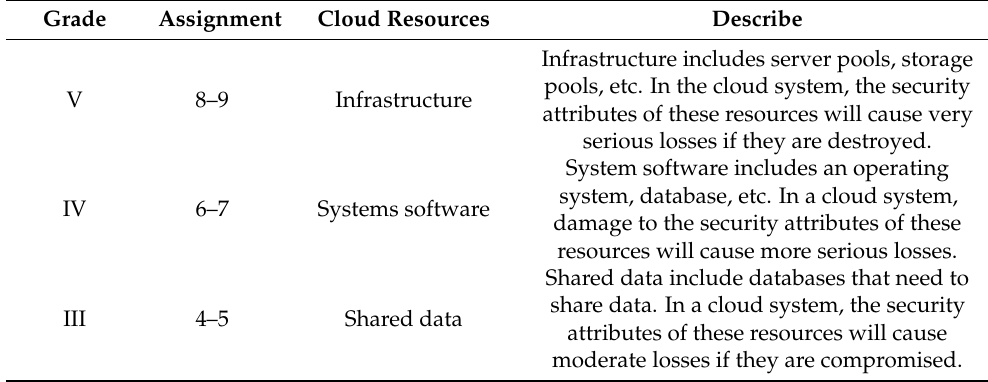
Table 3. Value level of medical